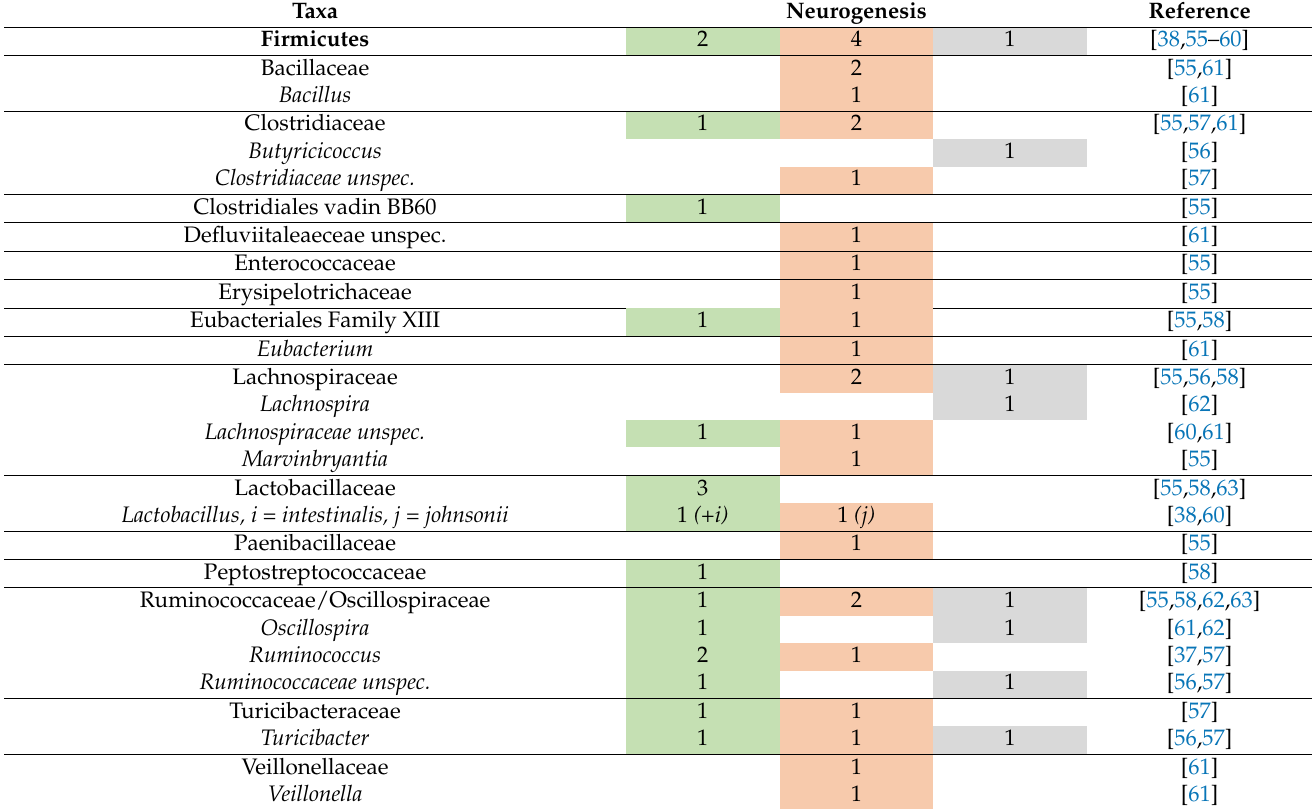
Table 3. Firmicutes and